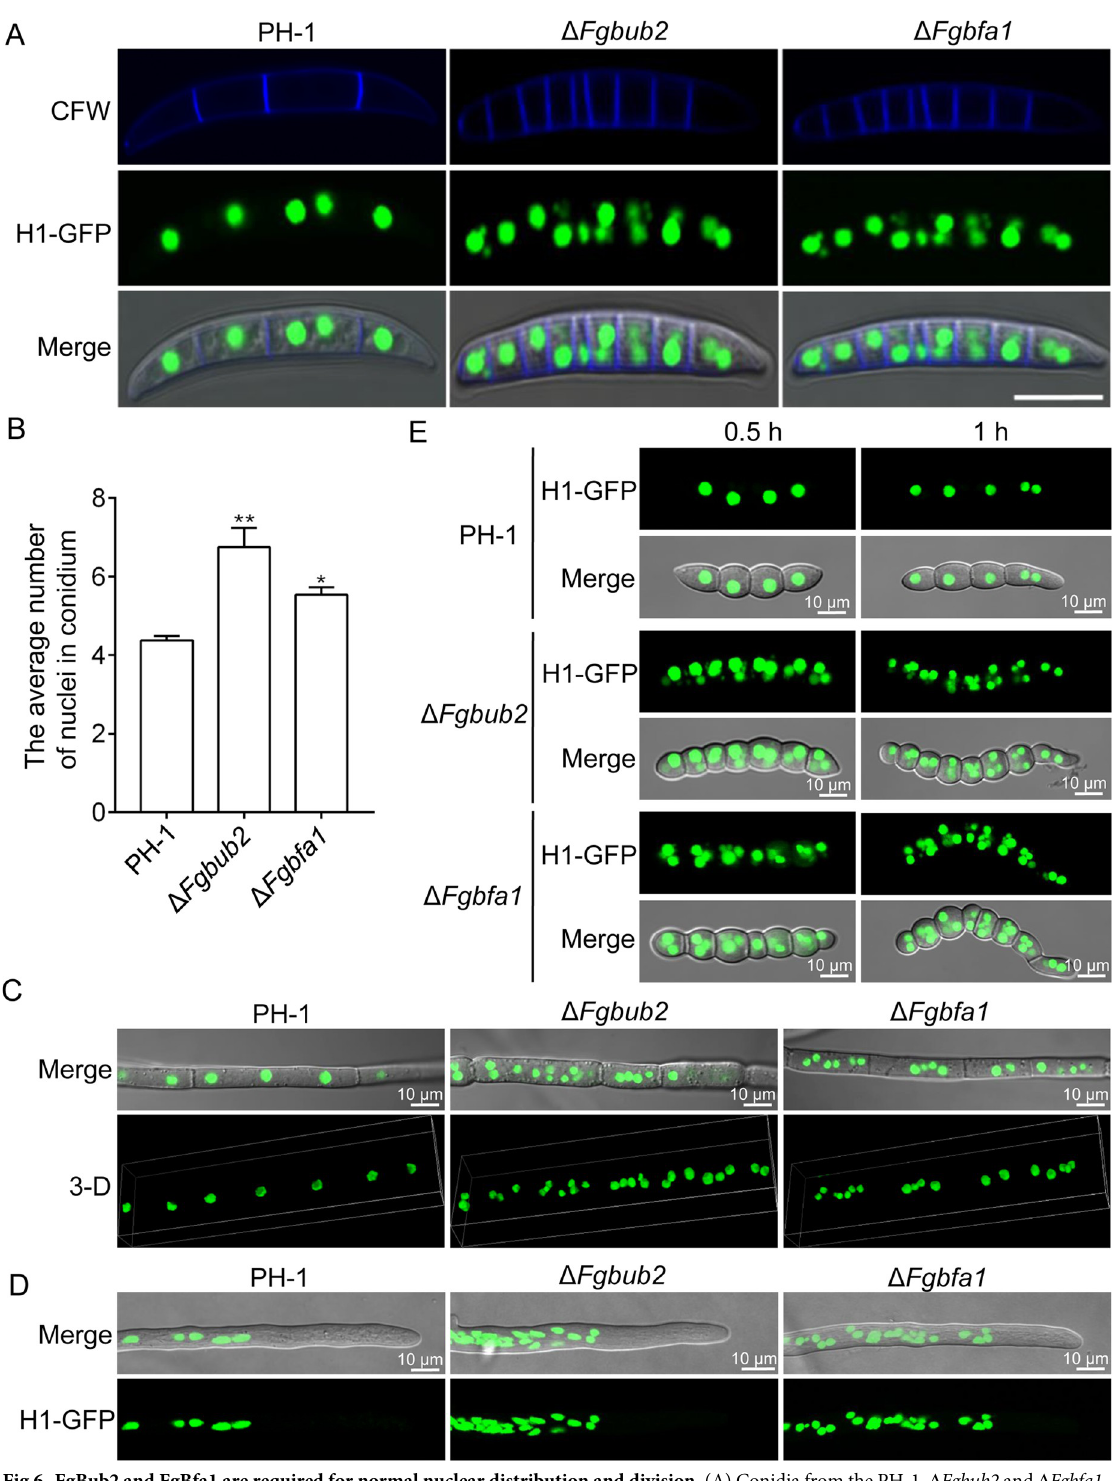
Fig 6. FgBub2 and FgBfa1 are required for normal nuclear distribution and division. (A) Conidia from the PH-1, Δ Fgbub2 and Δ Fgbfa1 strains expressing FgHistone1-GFP (H1-GFP) constructs. The images showing the distribution of nuclei in the conidia were taken after 3 days of incubation in CMC media under a fluorescence microscope. The conidia were stained with 10 μ g ml -1 of calcofluor white (CFW) prior to microscopy. (B) Statistical analysis of the average number of nuclei in conidium from three repeated experiments, at least 100 conidia of the indicated strains were counted in each experiment. Error bars represent the SD. Two-tailed Student t -test was used for paired